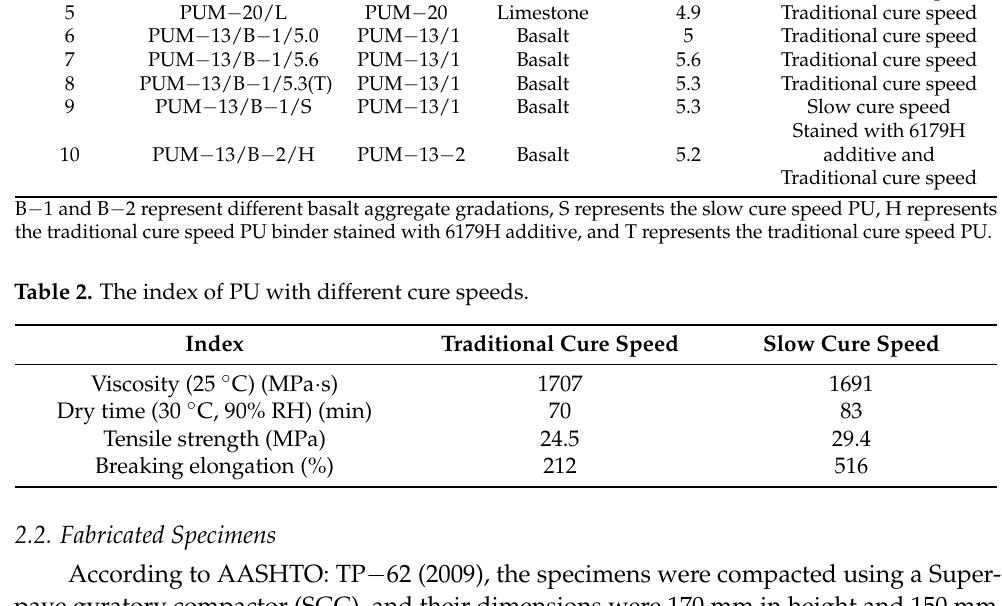
Table 1. The mixture gradation design combinations.